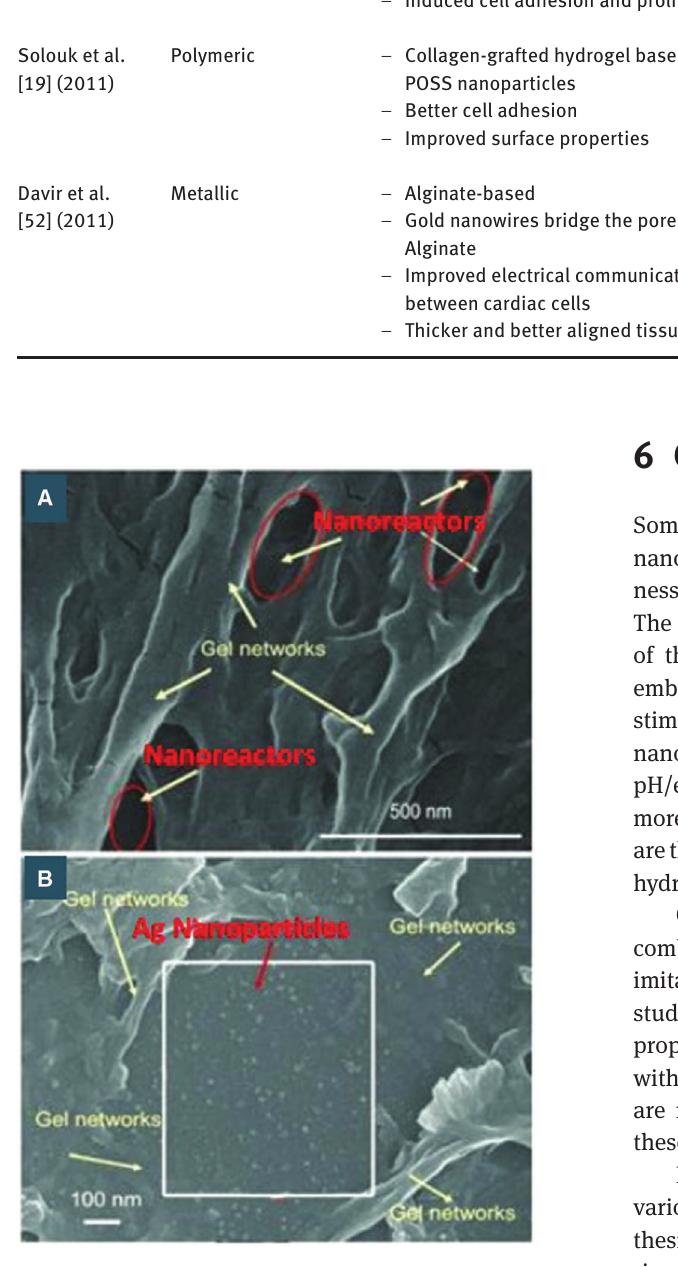
Figure 20: The SEM of (A) Pure hydrogel and (B) silver nanoparticle grown in crosslinked hydrogel network. Reprinted from Ref. [50], Copyright (2006), with permission from